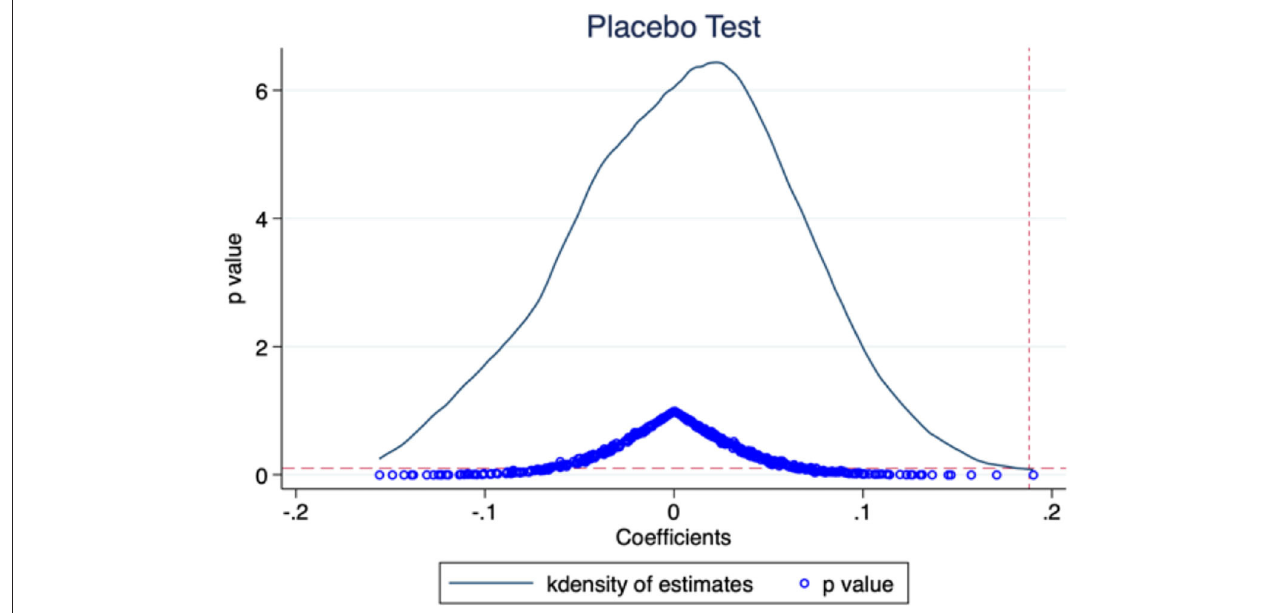
FIGURE 2 | Placebo test based on virtual grouping.